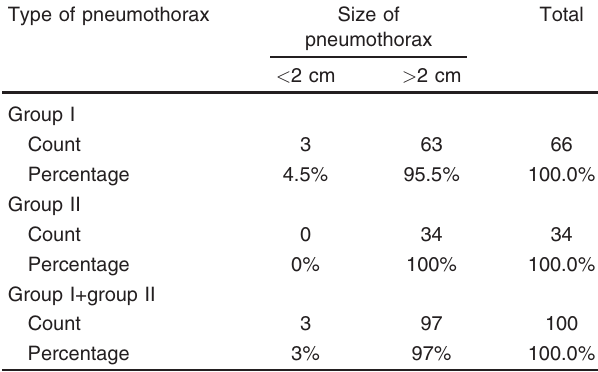
Table 4 Descriptive data of the size of pneumothorax in the studied patients